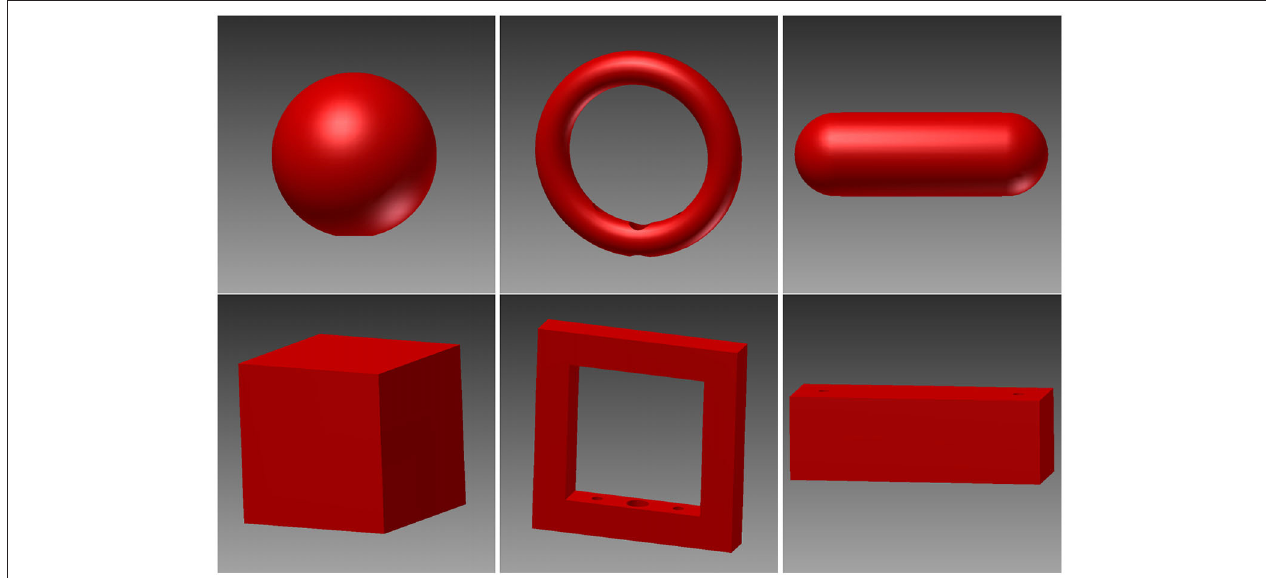
FIGURE 4 | 3D renders of the six objects. These objects were designed in pairs, where the two objects in the same column require a similar hand shape and grasp while looking and feeling differently. Top row: sphere, ring, and rounded bar. Bottom row: cube, edged version of the ring, and box.